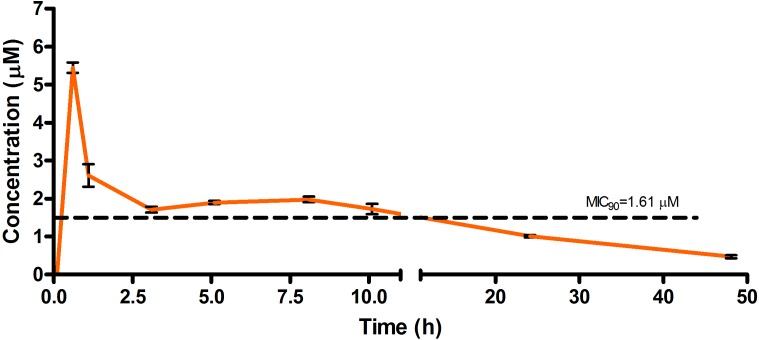
Total concentrations for RMB041 following oral administration in an uninfected murine model.